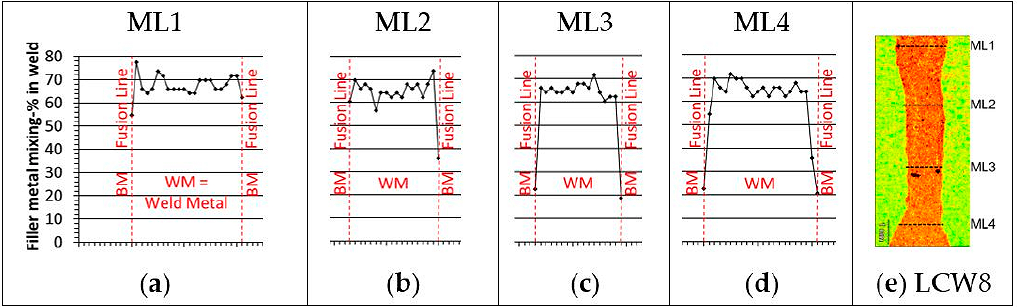
Figure 20. Filler metal mixing results from EDS stepwise characterization. ( a – d ) Filler metal mixing-% profiles of measurement lines 1–4 (ML1–ML4) from test weld LCW8 ( e ). In figures ( a – d ) one step between adjacent measurement points in the horizontal axis equals 100 micrometres.